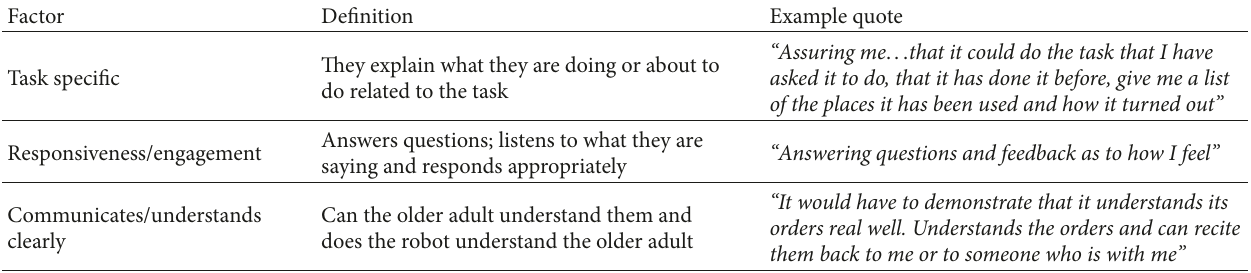
Table 7: Communication: definitions and examples of factors.